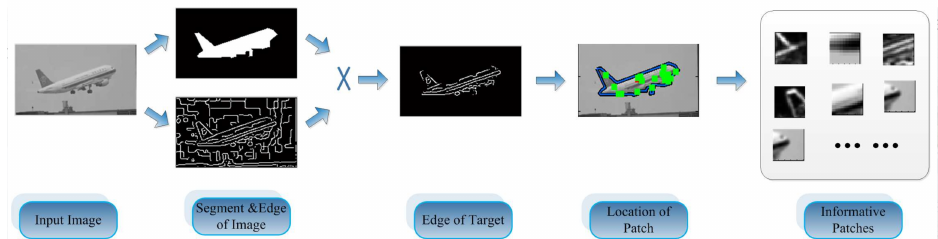
Figure 3. The informative patches were extracted from the location which includes rich edge